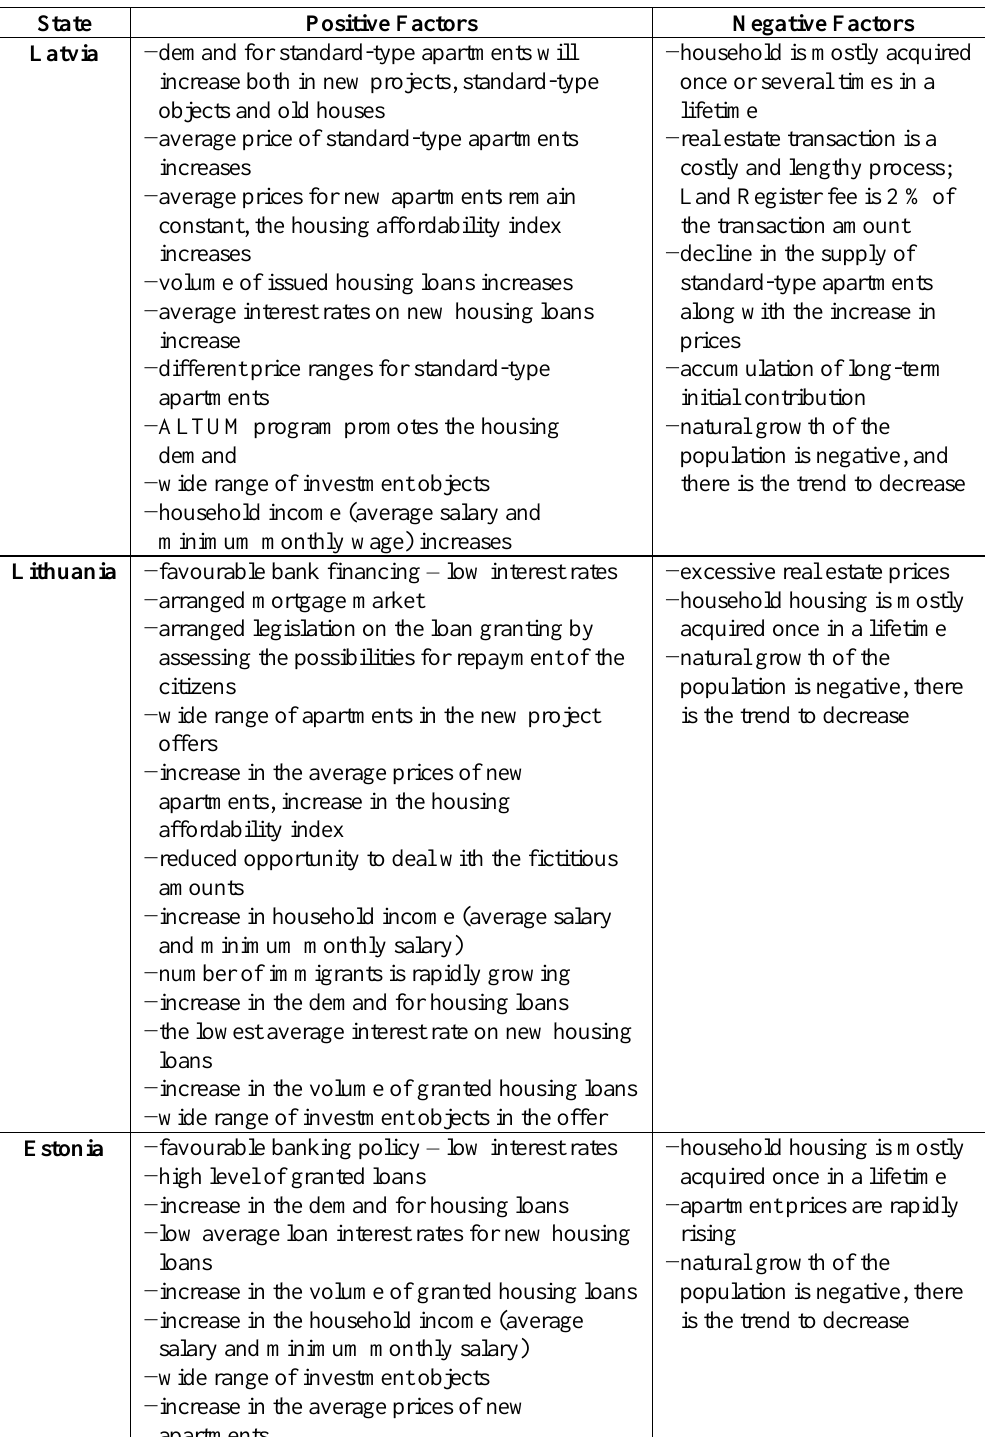
Table 5. Real estate market development trends in the transactions with residential areas in the Baltic States in 2016 (table made by authors) State Positive Factors Negative Factors